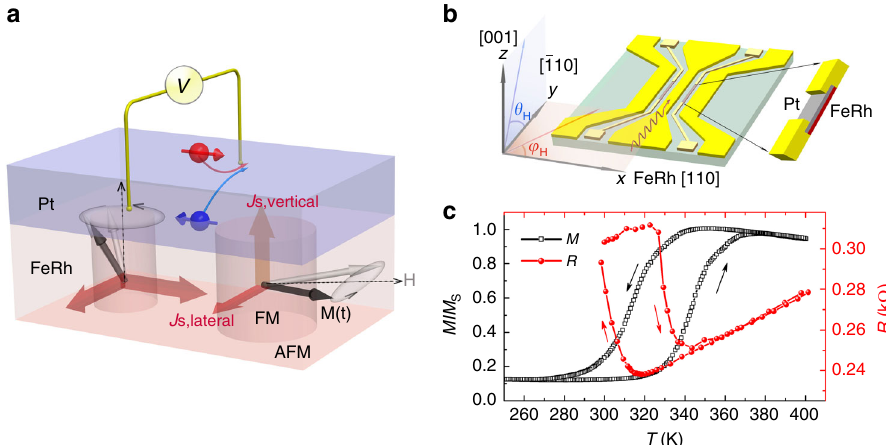
Fig. 1 Illustration of spin pumping and the magnetic phase transition of FeRh. a Illustration of vertical spin pumping by magnetization dynamics from FM- FeRh into Pt, and lateral spin pumping from FM-FeRh into AFM-FeRh during the phase transition. Due to the ultrathin thickness (10 nm) and relatively large in-plane domain size (the diameter ranges from hundreds of nm to μ m) of FeRh, the FM domains can be simply treated as fl at pillars and the magnetic easy axis lies in-plane. b Schematic of the measurement con fi guration for spin pumping. The FeRh/Pt bilayers were patterned into long stripes and integrated into the gap of a CPW. c Temperature-dependent normalized magnetization (black squares) and four-point resistance (red circles) of FeRh (10)/Pt.